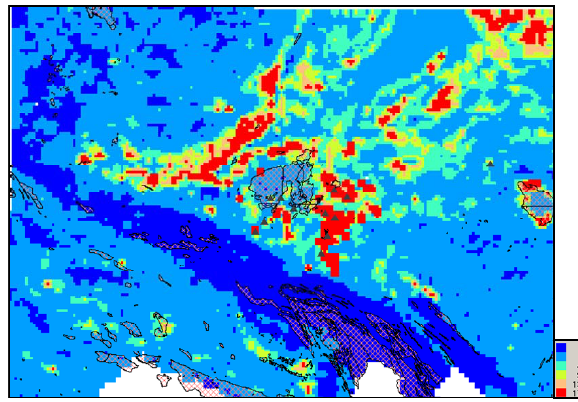
Fig. 2. A geochemical landscape created by As concentration values in ppm of stream sediment samples. The black polygons are mapped intrusions. The black triangles are tin mineral deposits.